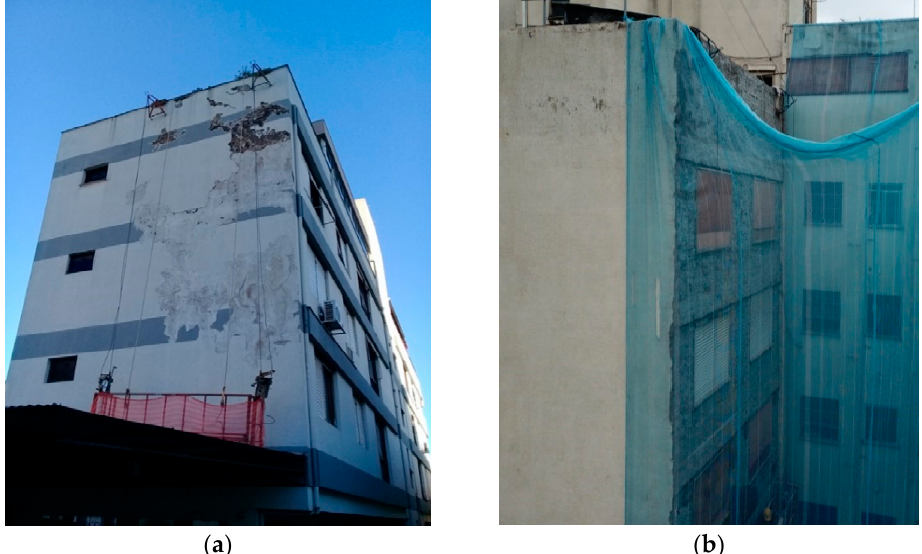
Figure 5. ( a ) Partial repair of a detached/not adhered area; ( b ) total removal of painted renderings.